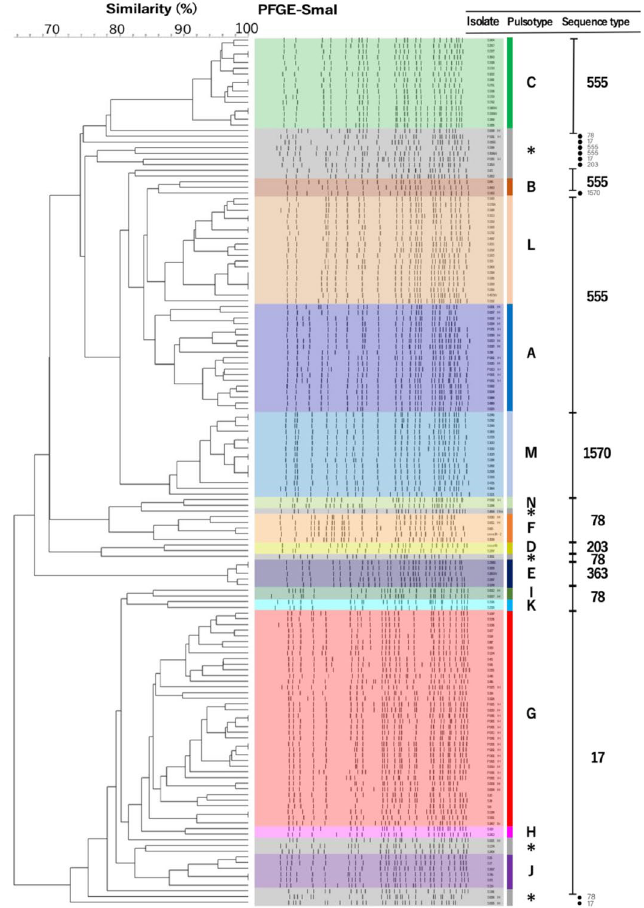
Figure 2. Dendrogram of pulsotypes in pulsed-field gel electrophoresis and sequence types in multilocus sequence typing among vancomycin-resistant Enterococcus faecium isolates (n = 153).